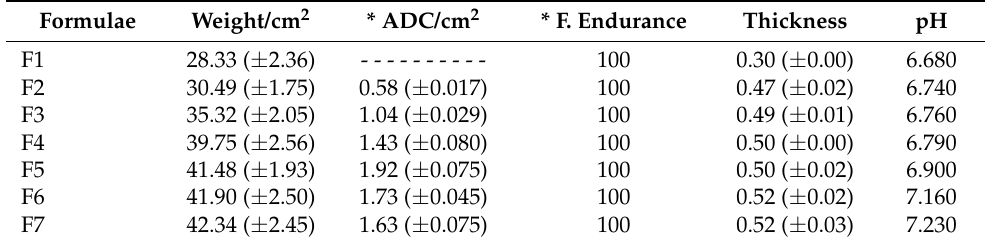
Table 2. Physical properties of the prepared CC buccal mucoadhesive